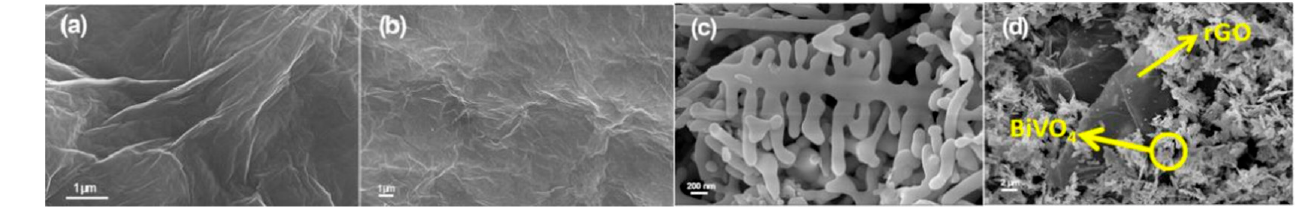
Figure 17. SEM images of ( a ) GO; ( b ) RGO; ( c ) pure pine dendritic BiVO 4 ; ( d ) BiVO 4 /RGO hybrid [122].